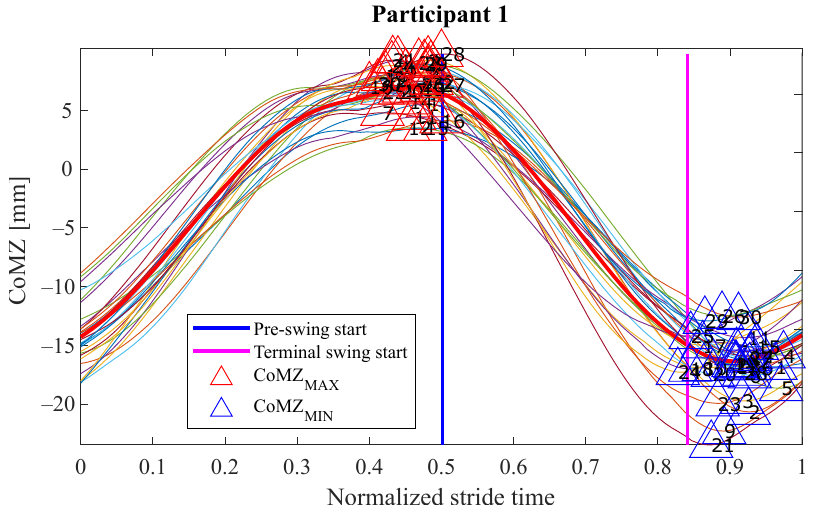
Figure 10. Evolution of the variable CoMZ for the test carried out by P1. The duration of the strides has been normalized to ease the visual inspection ( initial contact takes place at 0 in x -axis and the stride finishes at 1). The red line is the mean of CoMZ considering all the gait cycles involved. The vertical lines represent the mean time in which those phases started. In this case, gait events can be seen just before the pre-swing phase and during the terminal swing phase, in form of maximums and minimums of CoMZ , respectively. The former may be used to anticipate the pre-swing phase and the latter to do the same with the initial contact of the following stride (it would take place at 1 in x